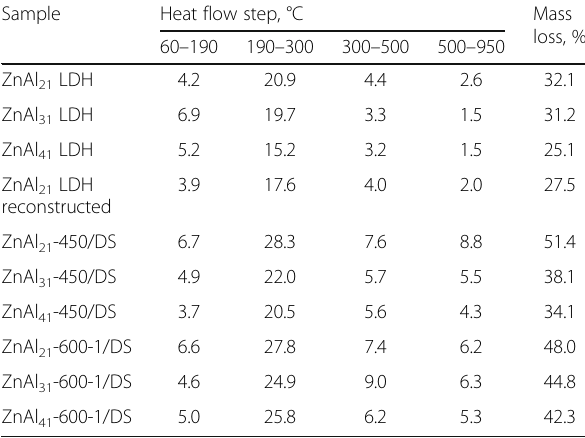
Table 1 TG and DTG results for the Zn-Al LDHs